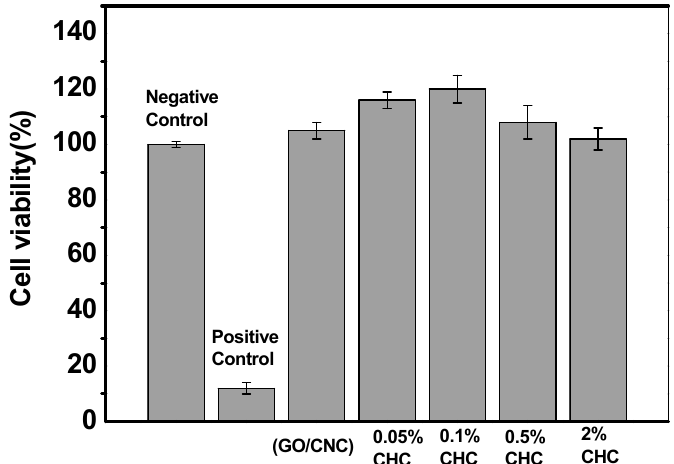
Figure 8. Cell proliferation of L929 cell with negative control and the CHC / GO / CNC nanocomposite hydrogel with the various CHC concentrations of 0.05, 0.1, 0.5, and 2 wt% (negative control: DMEM + Table 1. Antibacterial activity of CHC / GO / CNC nanocomposite hydrogels. Microorganism Type Bacteriostatic Ratio (%) (Ratio of MBC to MIC) Escherichia coli gram-negative > 99.99 Staphylococcus aureus gram-positive 97.5 Candida albicans fungus 94.1